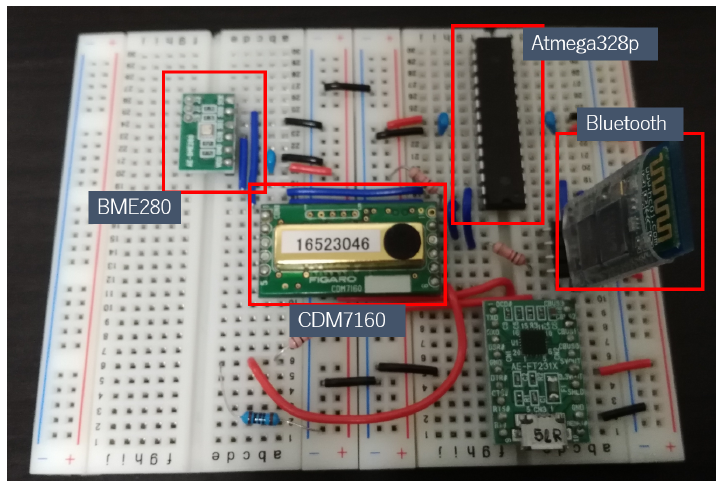
Figure 2. Measurement device